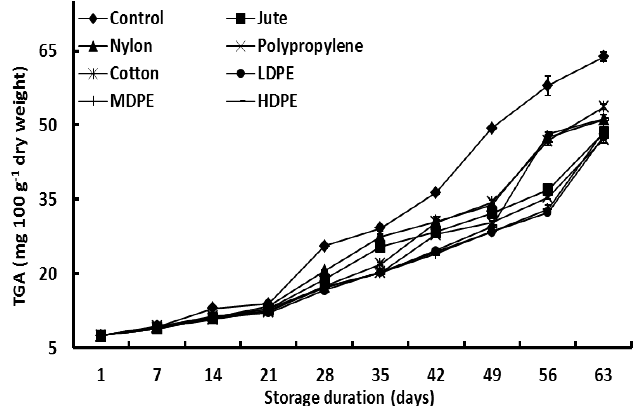
Fig. 4: Total glycoalkaloids (TGA) in potato tubers stored using different packaging materials was highest in non-packaged controls by the end of the storage period. Vertical bars show ±SE of means (n-3). Interaction between storage intervals and packaging materials was significantly different at p ≤ 0.05.